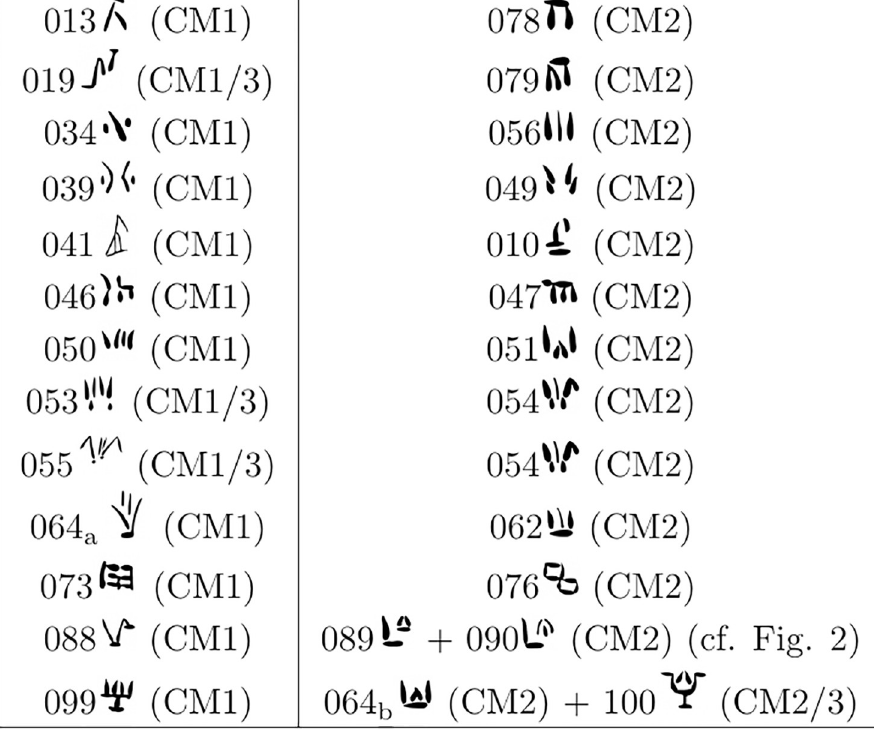
Fig 11. Pairs of CM1 (left column) / CM2 (right column) signs in complementary distribution and hypothesized as variants of the same grapheme.